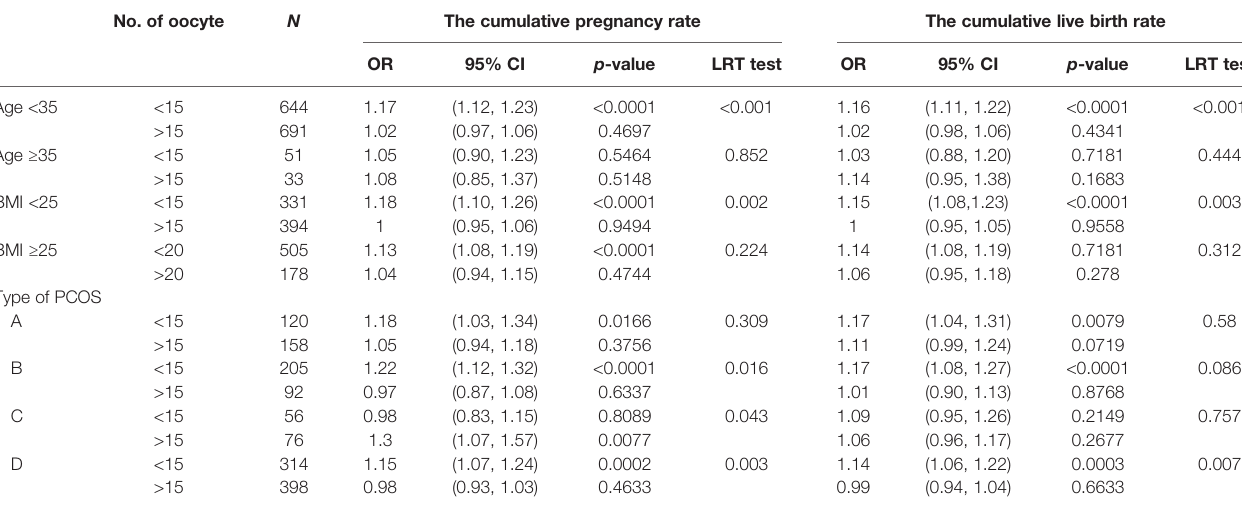
TABLE 6 | Effect of age, BMI, and type of PCOS on the association between the number of oocytes retrieved and cumulative clinical outcomes. No. of